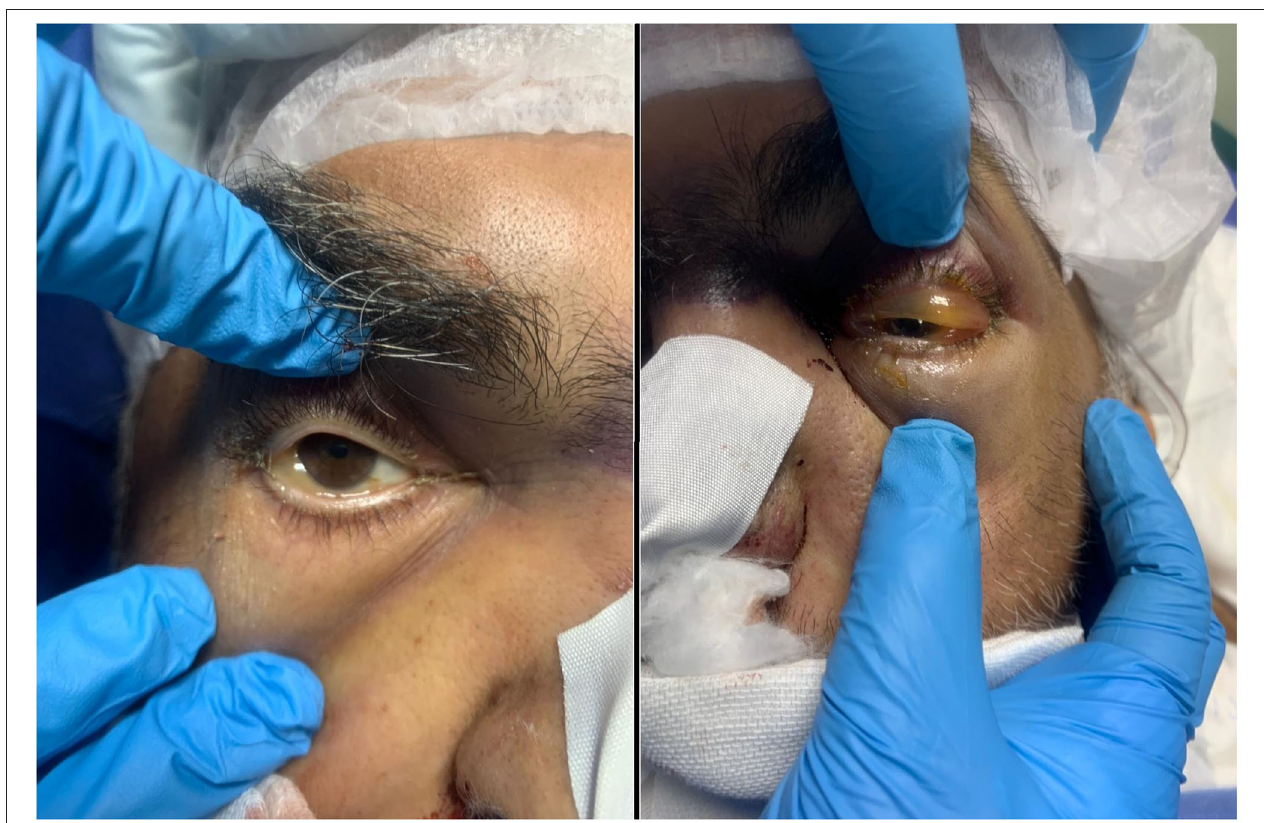
FIGURE 1 | Presenting signs in one of the cases. Moderate conjunctival chemosis in the right eye and severe conjunctival chemosis with lid swelling in the left eye in a 54-year-old male patient, diabetic, with chronic kidney disease, on mechanical ventilation in the intensive care unit for severe COVID-19.